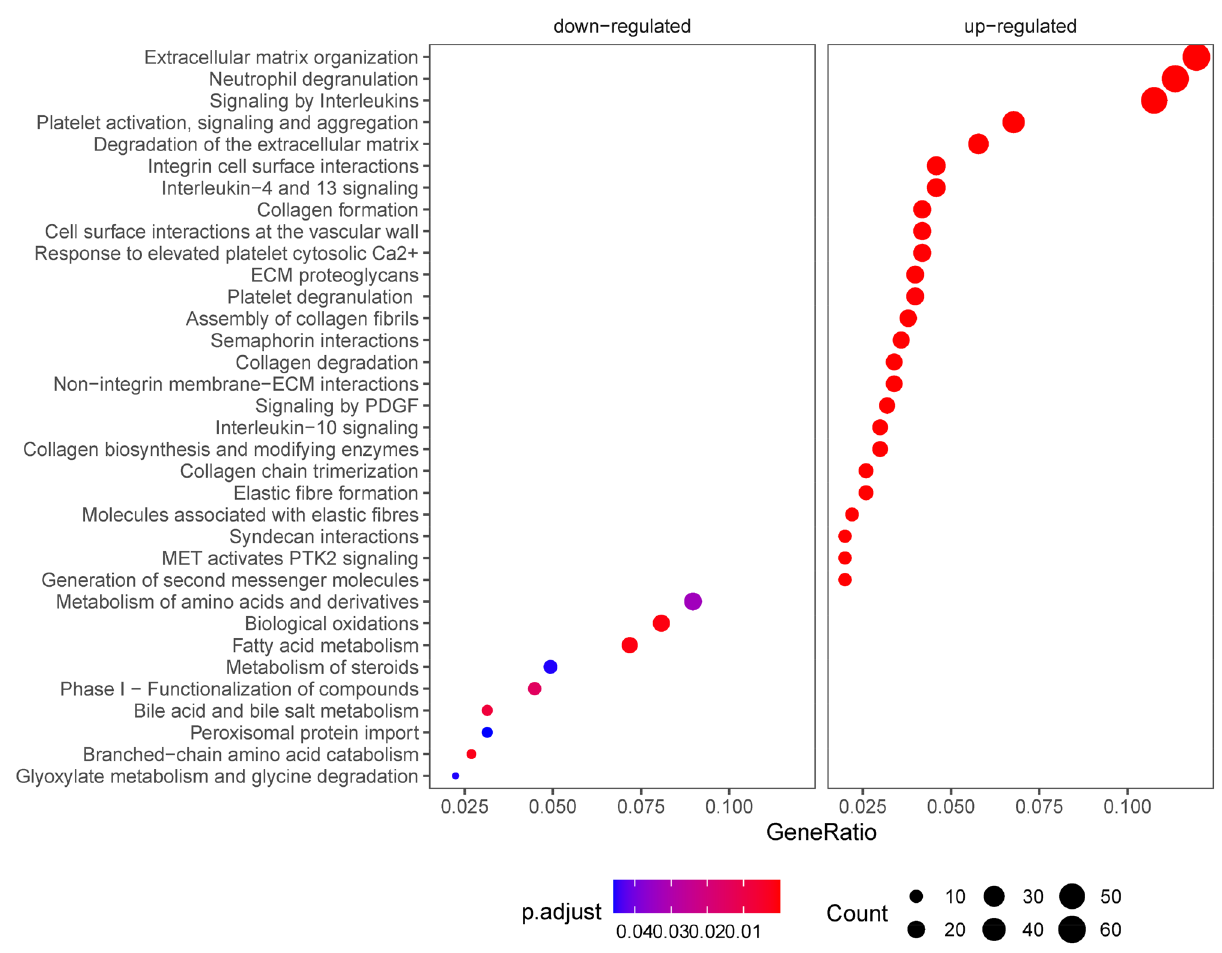
Figure 2. Gene set enrichment analysis. Enrichment of Reactome pathways by up-regulated (clusters 2 and 3) and down-regulated (clusters 4 and 15) DE genes. Colors represents the adjusted P value and the size of each dot represents the number of DE